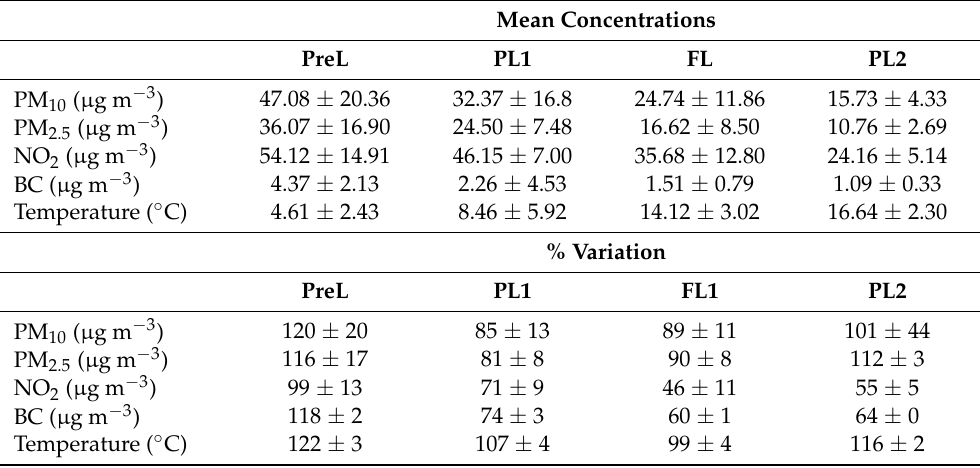
Table 3. Reference scenario of air quality in the investigated area: means and standard deviation values of 2018–2019 aggregated data computed in each time span corresponding to different lockdown periods. Impact of lockdown restrictions measured: % bias of air quality data in 2020 compared with 2018–2019 values in each equivalent period. Mean